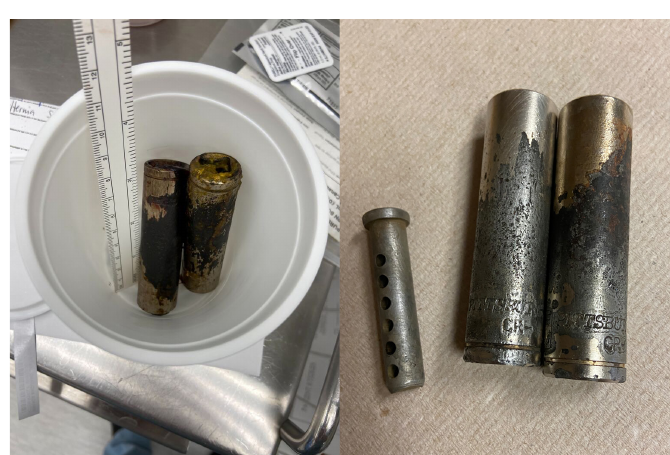
Image 3. Images of the retrieved foreign bodies in the operating room, which were reported to be two AA batteries per the patient. Closer evaluation reveals foreign bodies are two, approximately 3.5-cm metal sockets typically used with a socket wrench and a clevis pin, which was nested within one of the sockets creating the illusion of an AA battery silhouette on plain